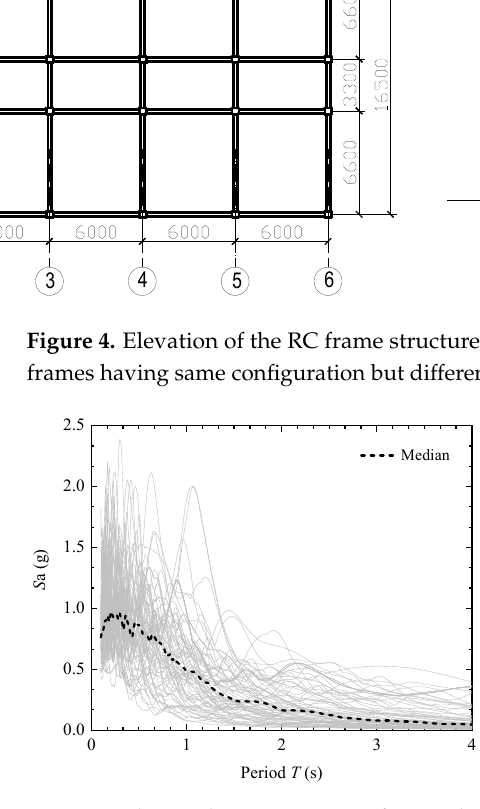
Figure 5. The acceleration spectra of ground motions (PGA = 0.45 g).